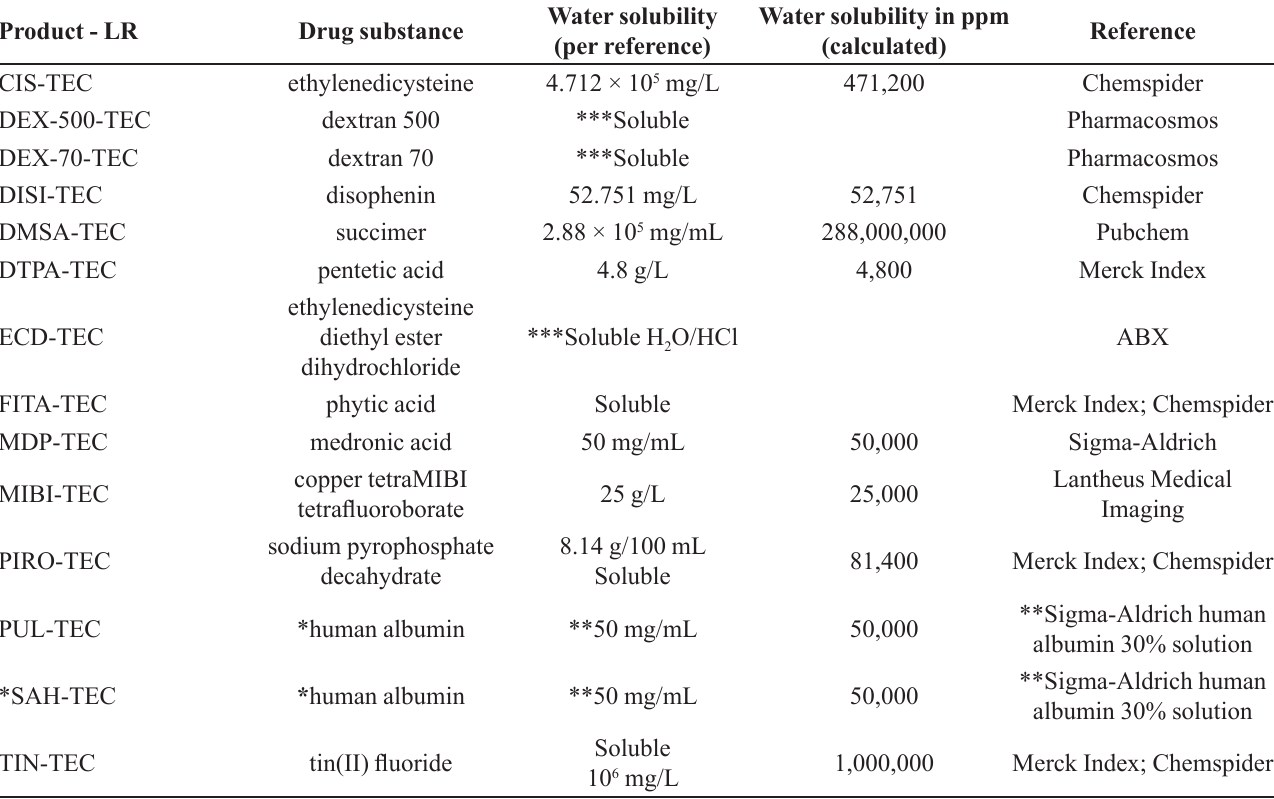
TABLE IV - Solubility data for LR manufactured at